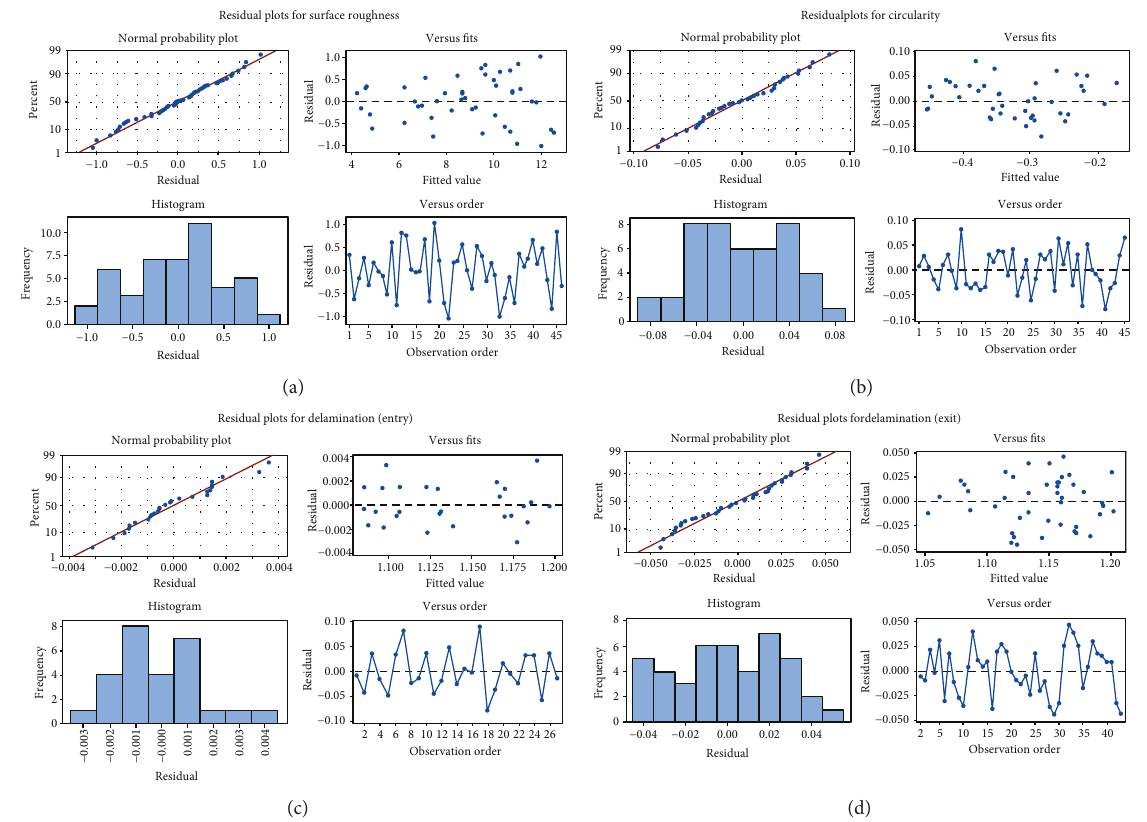
Figure 10: Residual plots: (a) surface roughness, (b) circularity, (c) delamination at entry, and (d) delamination at exit.